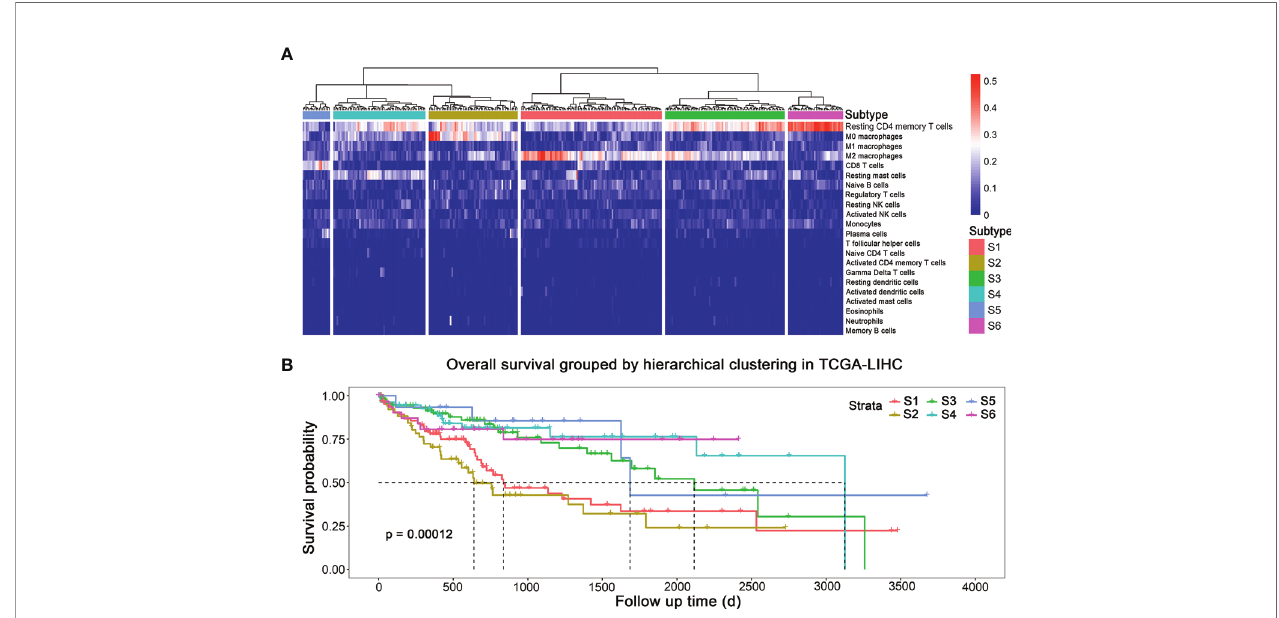
FIGURE 1 | Subtypes of HCC with different prognosis based on immune cells in fi ltration. (A) Immune subtypes. (B) Survival curves of different